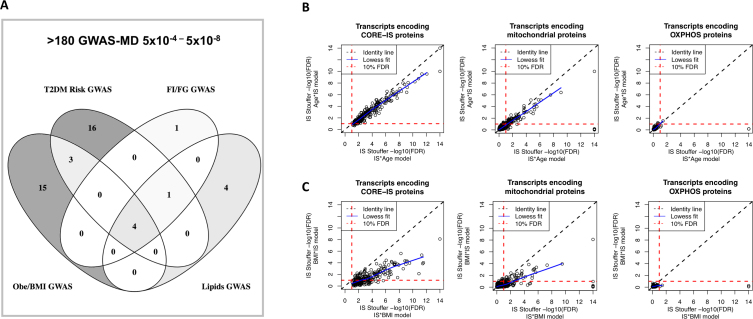
Relationship with GWAS-MD loci and the impact of covariate modeling on insulin sensitivity relationship with gene expression. (A) The majority of CORE-IS genes located at genome wide significant metabolic disease loci (GWAS, 5 × 10−8), were related to either ‘risk of developing T2DM’ (24) or ‘Obesity/BMI’ (22), partly reflecting the greater number of such loci, over those known to influence fasting insulin or glucose. See Table 2 for details of ∼180 genes; for what the Diabetes consortium defined as marginal GWAS loci (5 × 10−4). (B) When the relationship between IS and RNA is studied using ANOVA and a covariate, e.g., age or BMI, the model yields P-values for both variables, where the outcome depends on the order in the linear model and the inter-relationship between IS and Age/BMI. The log10 false discovery rate (FDR) values (using the Stouffer method and a calculated FDR (60)) are plotted for three gene-sets (CORE-IS ENST, mitochondrial located genes and the Mootha et al. (26) defined OXPHOS gene-set) from the two different models, IS*age and age*IS. As can be seen, the vast majority of CORE-IS genes remain significant when adjusted for age (i.e. age*IS) as compared to IS*age, but with a small systematic loss in statistical significance. There are only two significant OXPHOS genes, one down-regulated with better IS, and one of which is related to an interaction with age. (C) The log10 false discovery rate (FDR) values are plotted for three gene-sets (the CORE-IS ENST, mitochondrial located genes and the OXPHOS gene-set) from the two different models, IS*BMI and BMI*IS. As can be seen, there is a systematic loss in statistical significance when BMI is adjusted for (BMI*IS) in the model as compared to IS*BMI. Approximately 38% of the CORE-IS protein coding genes FDR-values are no longer significant when BMI is considered first, in the ANOVA Type I model, while a further 33 are identified, with a proportionate gain in new GWAS-MD loci (mainly for BMI or Obesity) when this alternate model is used.